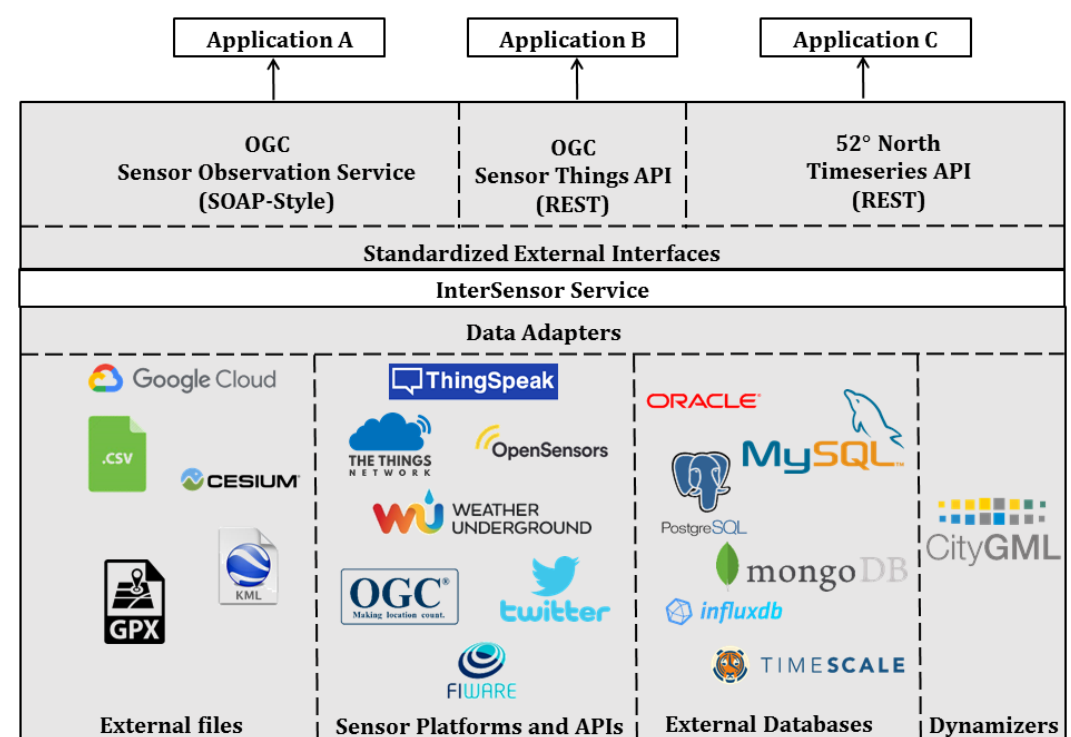
Figure 3. The three-layer architecture of InterSensor Service. The service can be instantiated for individual data sources using adapters and provides standardized external